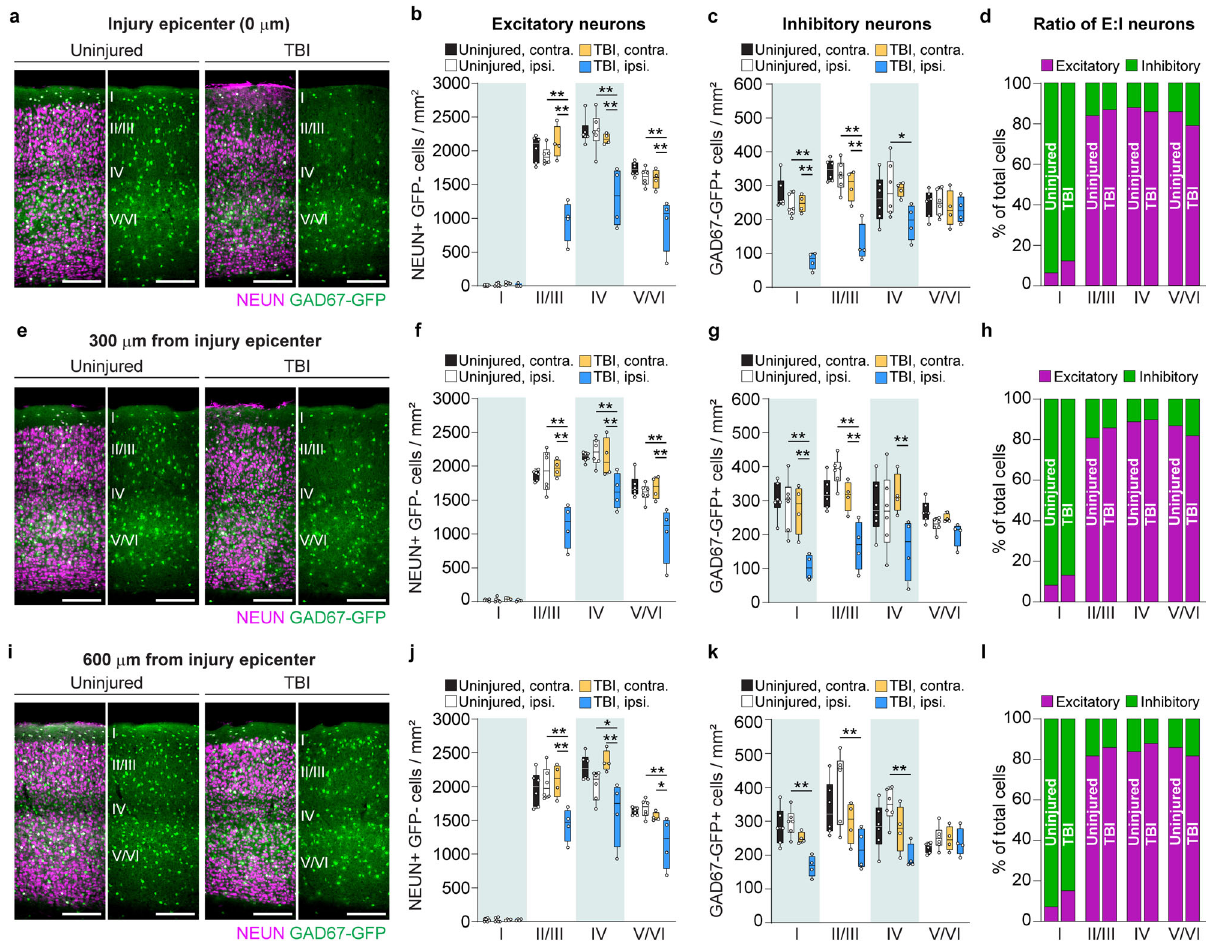
Fig. 3 V1 injury produces subtype- and layer-speci fi c loss of neurons. a, e, i Coronal images of control and CCI-injured V1 labeled for NEUN (magenta) and GAD67-GFP (green) at 0 ( a ), 300 ( e ), and 600 μ m ( i ) from the injury. b, f, j Quanti fi cation of NEUN + /GFP- cell density in layers I, II/III, IV, and V/VI. N = 4 – 6 mice per group. c, g, k Quanti fi cation of GAD67-GFP cell density in layers I, II/III, IV, and V/VI. N = 4 – 6 mice per group. d, h, l Analysis of the proportion of excitatory to inhibitory neuron density at the injury site (Chi-square = 2.17, df = 3, P = 0.54; d ), 300 μ m (Chi-square = 1.32, df = 3, P = 0.72; h ), or 600 μ m caudal to the epicenter (Chi-square = 2.68, df = 3, P = 0.44; l ). Scale bars, 500 μ m. Box and whisker plots show median, 25th and 75th percentiles, and the whisker bars represent maximum and minimum values. ** P <0.01, * P <0.05; random intercept mixed model with Tukey-Kramer post hoc test. See Supplementary Data 2 for statistical